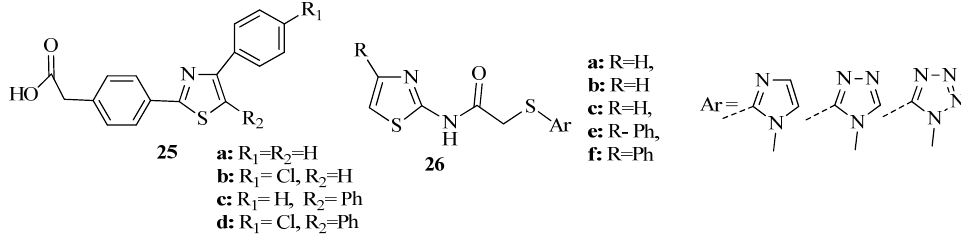
Figure 11. Structures of thiazole phenylacetic acid derivatives ( 25 ) and 2-[(1/4- methylimidazol/triazol/tetrazol-2/3/5-yl) thio]- N -(4-substituted thiazol-2-yl) acetamide derivatives ( 26